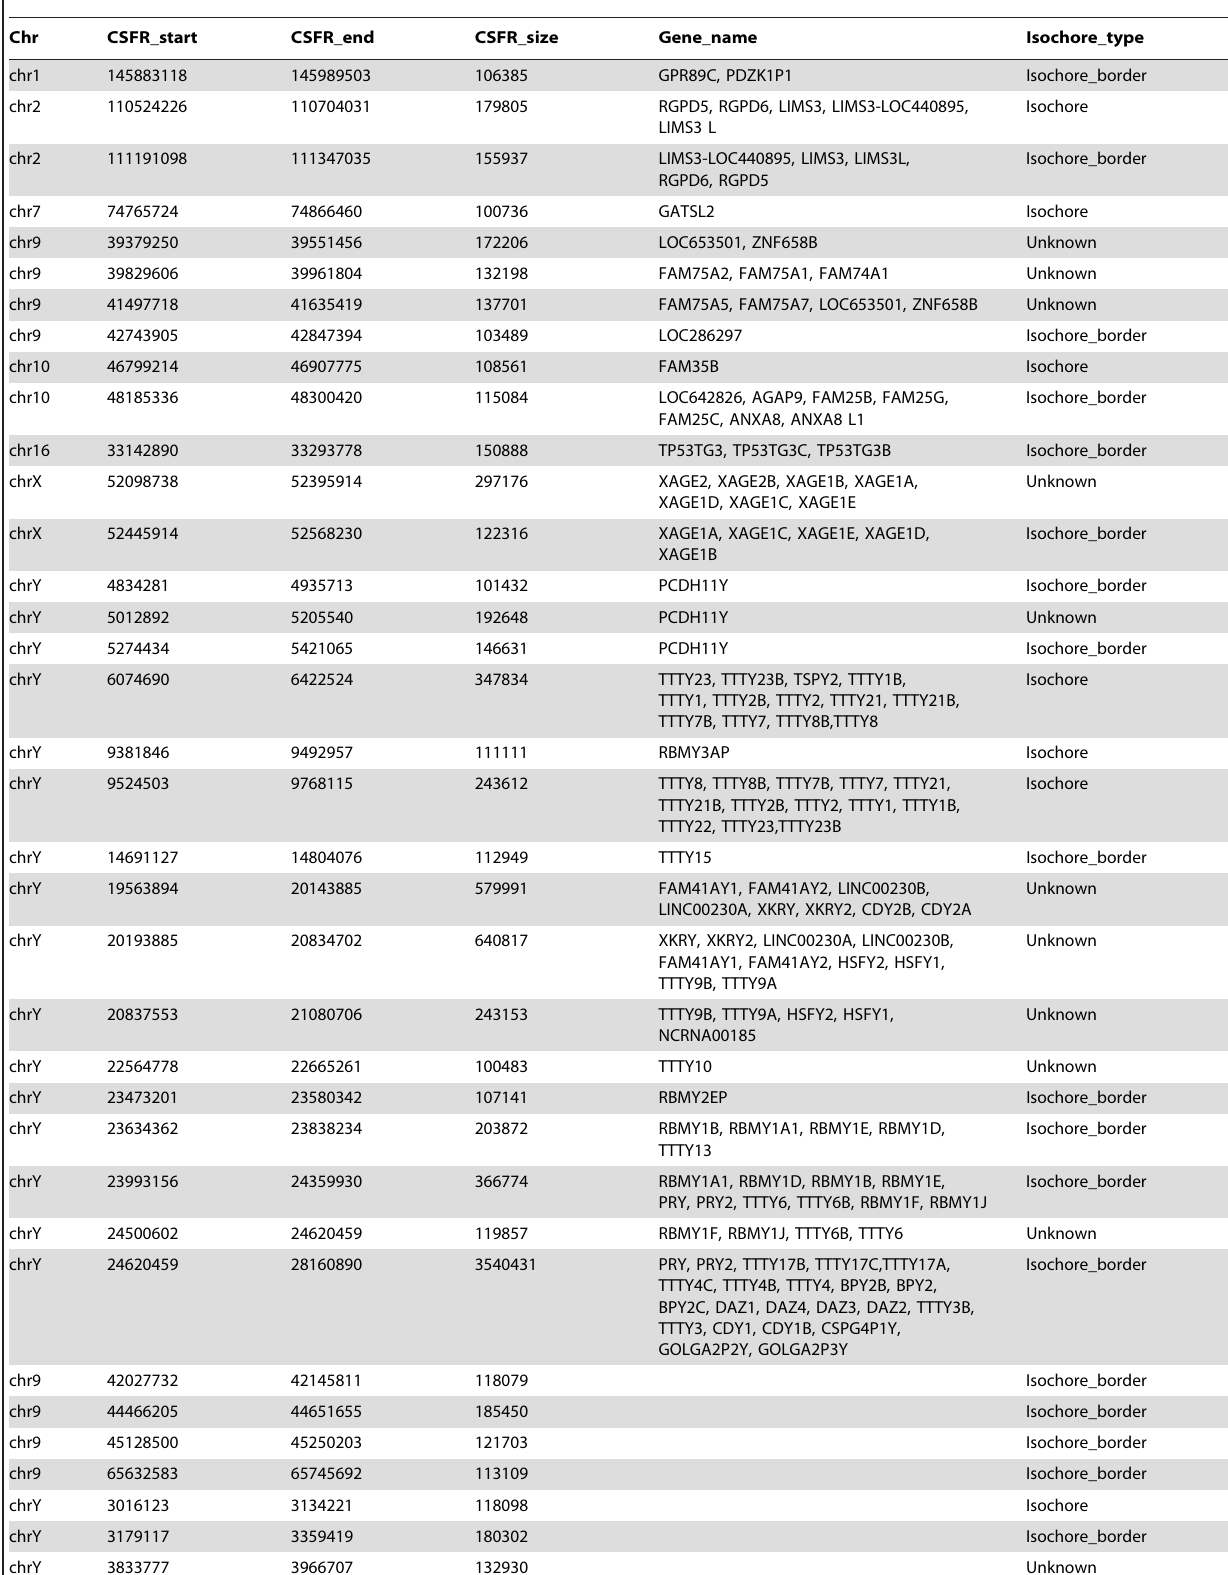
Table 2. List of 50 common SNP-free regions containing 97